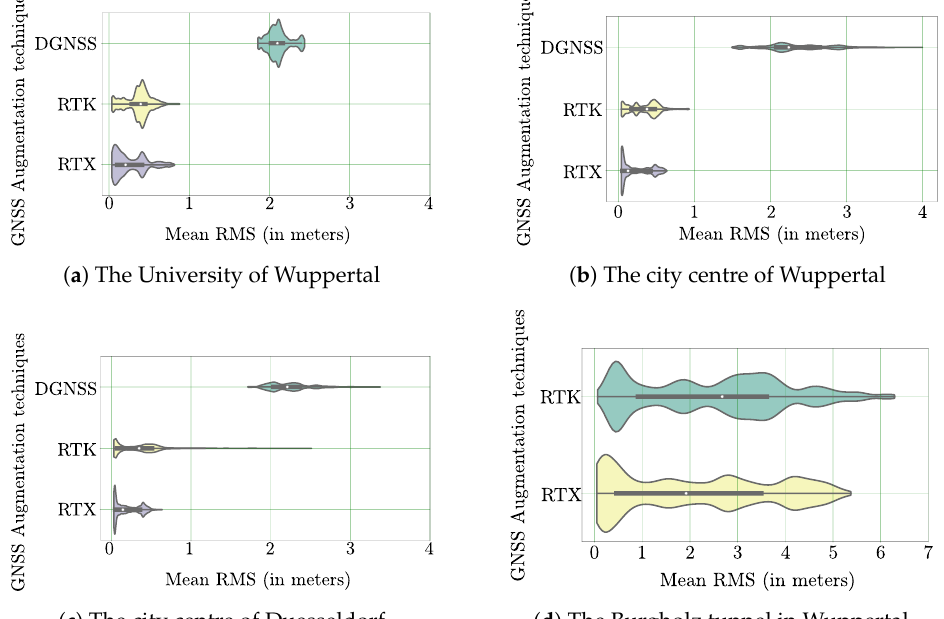
Figure 6. Horizontal violin plots showing the distribution of RMS values across various position augmentation techniques for each test region. The white dot represents the median RMS error value, the thick grey bar in the center represents the interquartile range and the thin grey line represents the rest of the